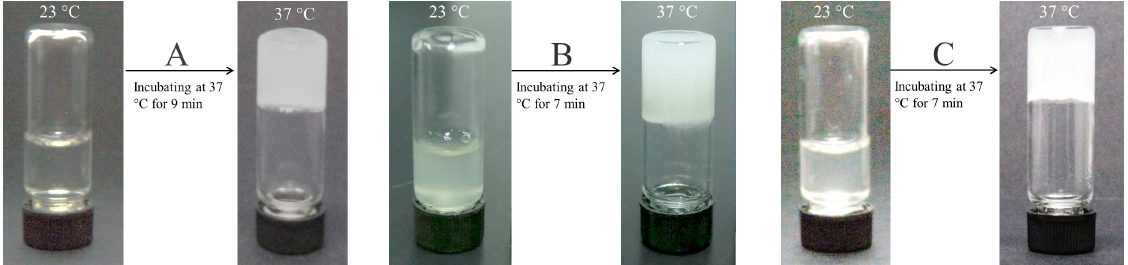
Figure 4. Photos for the sol-gel transition of CH/GP gel ( A ), CH/AN2/GP gel ( B ) and CH/AN5/GP gel ( C ) incubated at 37 ° C for varied periods of times (see Figure 3 for the composition of these gels).